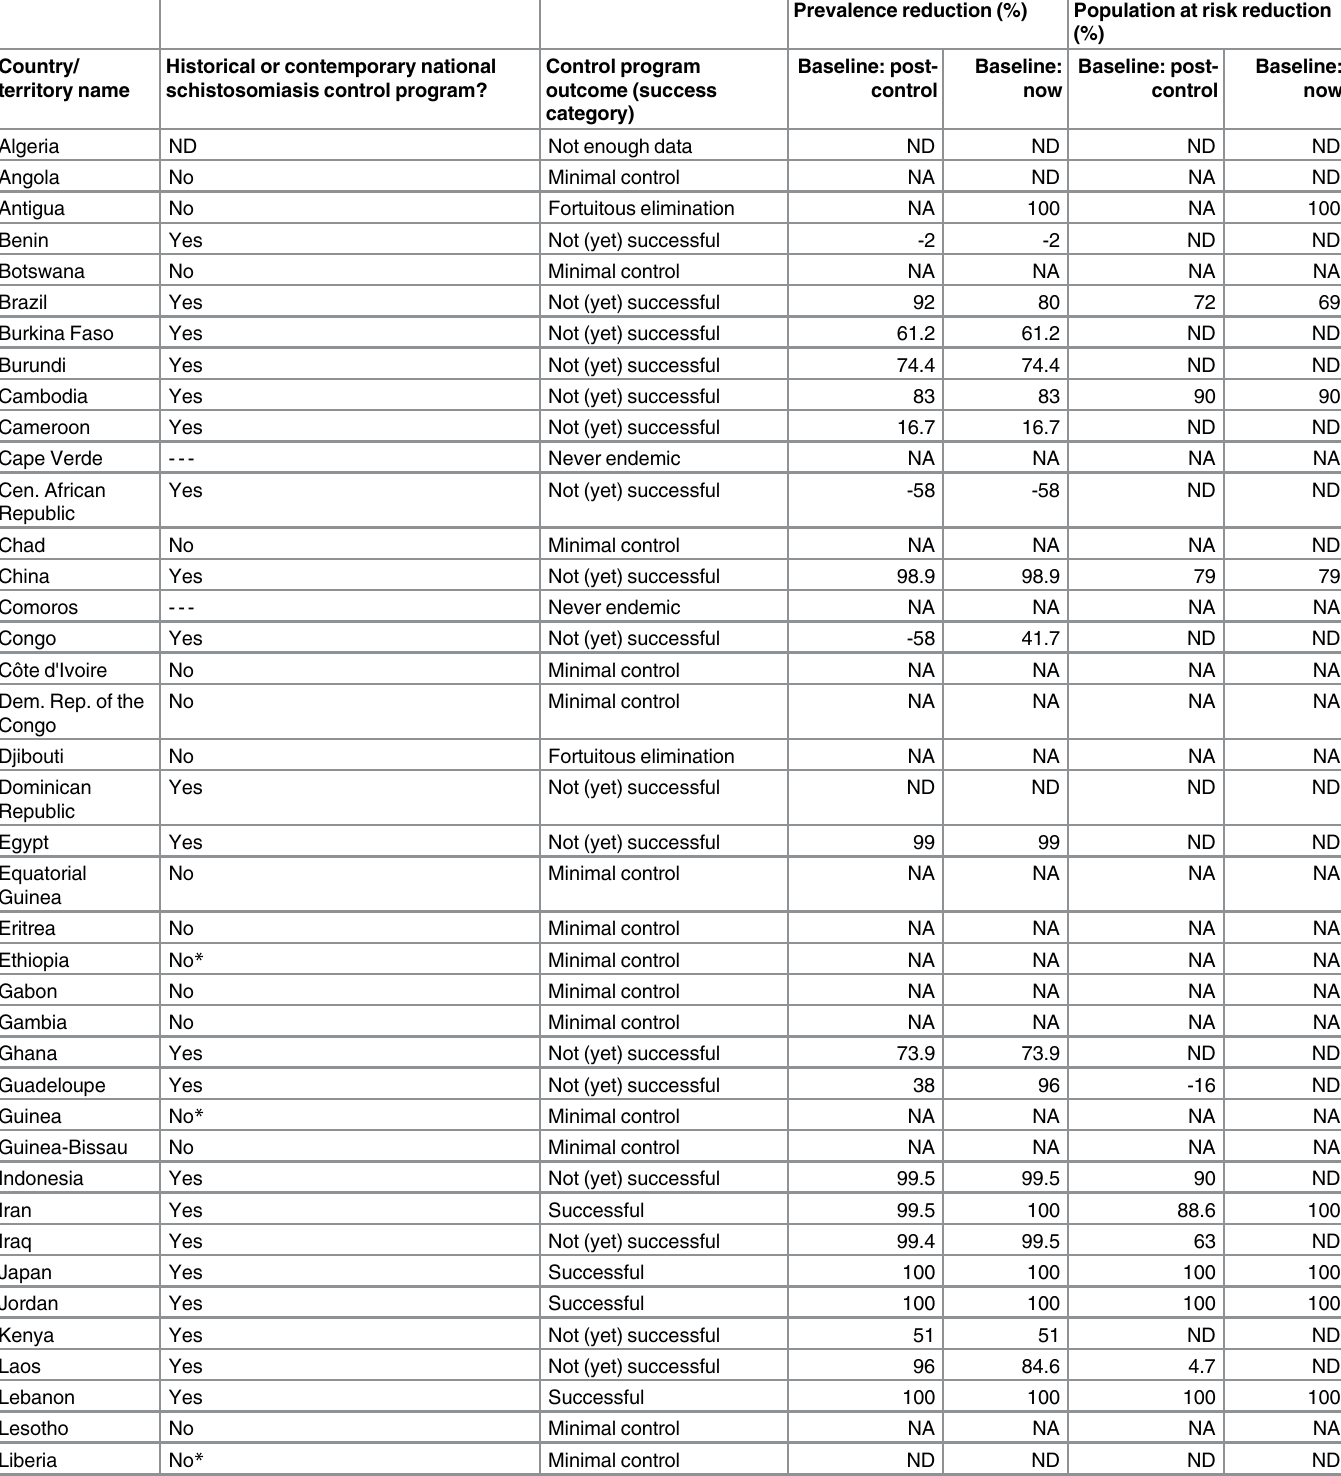
Table 1. Countries and territories evaluated and their success categories, prevalence reduction, and percent reduction in population at risk for schistosomiasis (as a proportion of the total population).